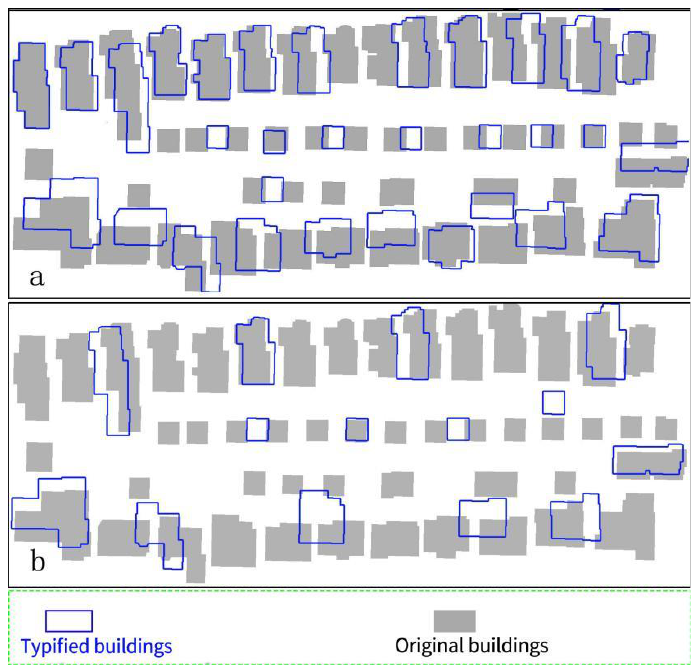
Figure 8. Relocation of buildings based on the maximum area. ( a ) Typified buildings of small aperture superpixel. ( b ) Typified buildings of big aperture superpixel.